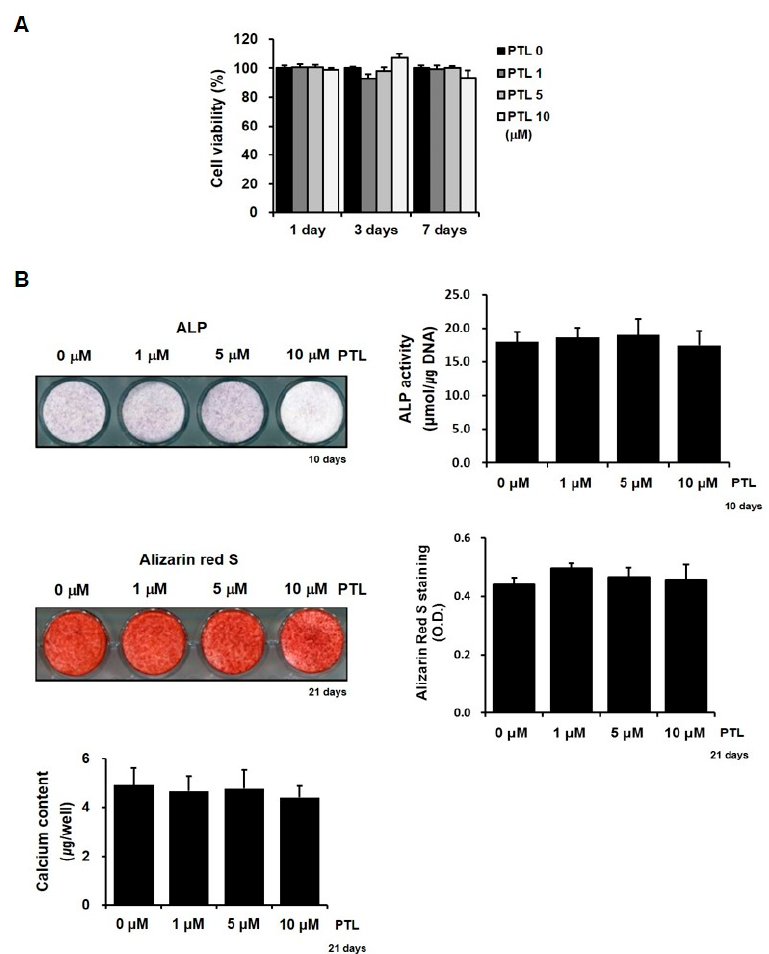
Figure 1. PTL has no significant effects on hPDCs in vitro. There was no significant effect of PTL on the cell viability of hPDCs ( A ). PTL also did not clearly affect the in vitro osteoblastic differentiation of hPDCs, regardless of concentrations ( B ).